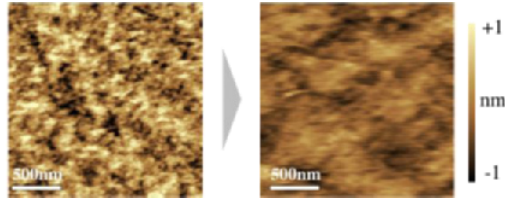
Fig. 3. AFM images (2μm × 2μm) of the as-received (left) and CARE-processed (right) LN